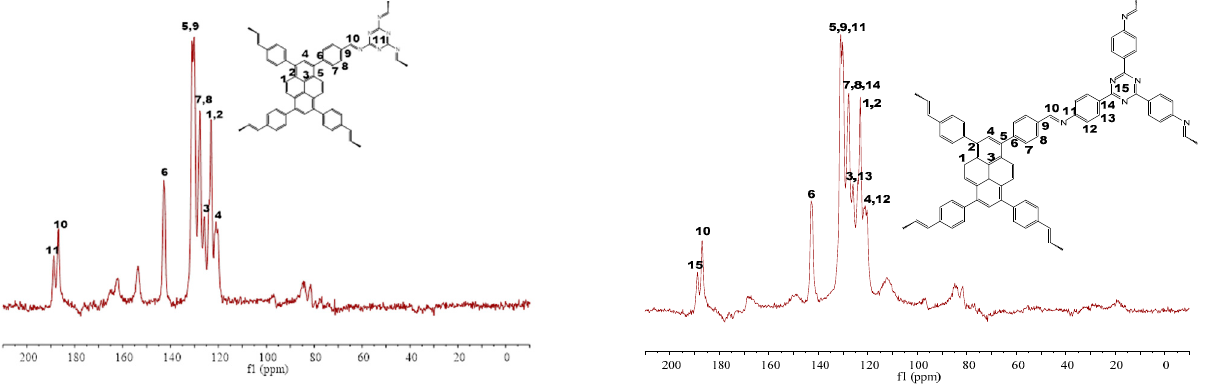
Figure 4. Solid-state 13 C CP − MAS NMR spectrum of CMP − shu − 1 ( left ) and CMP − shu − 2 ( right ). The Figure 4. Solid ‐ state 13 C CP − MAS NMR spectrum of CMP − shu − 1 ( left ) and CMP − shu − 2 ( right ). The Figure 4. Solid-state 13 C CP-MAS NMR spectrum of CMP-shu-1 ( left ) and CMP-shu-2 ( right ). The number in the structure figure means the carbon types, to correspond to the CP-MAS. number in the structure figure means the carbon types, to correspond to the CP ‐ MAS. number in the structure figure means the carbon types, to correspond to the CP-MAS. Figure 4. Solid ‐ state 13 C CP − MAS NMR spectrum of CMP − shu − 1 ( left ) and CMP − shu − 2 ( right ). The number in the structure figure means the carbon types, to correspond to the CP ‐ MAS.